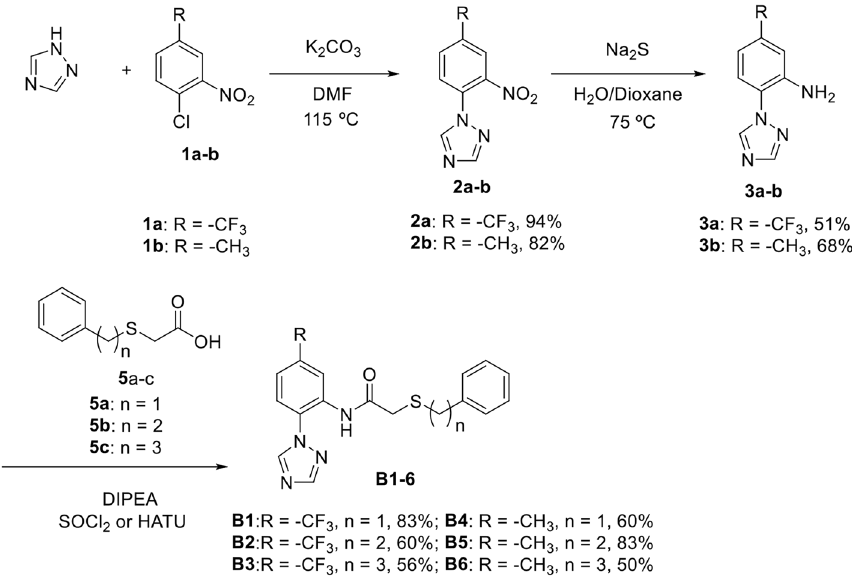
Figure 5. Synthesis of B1-6 target